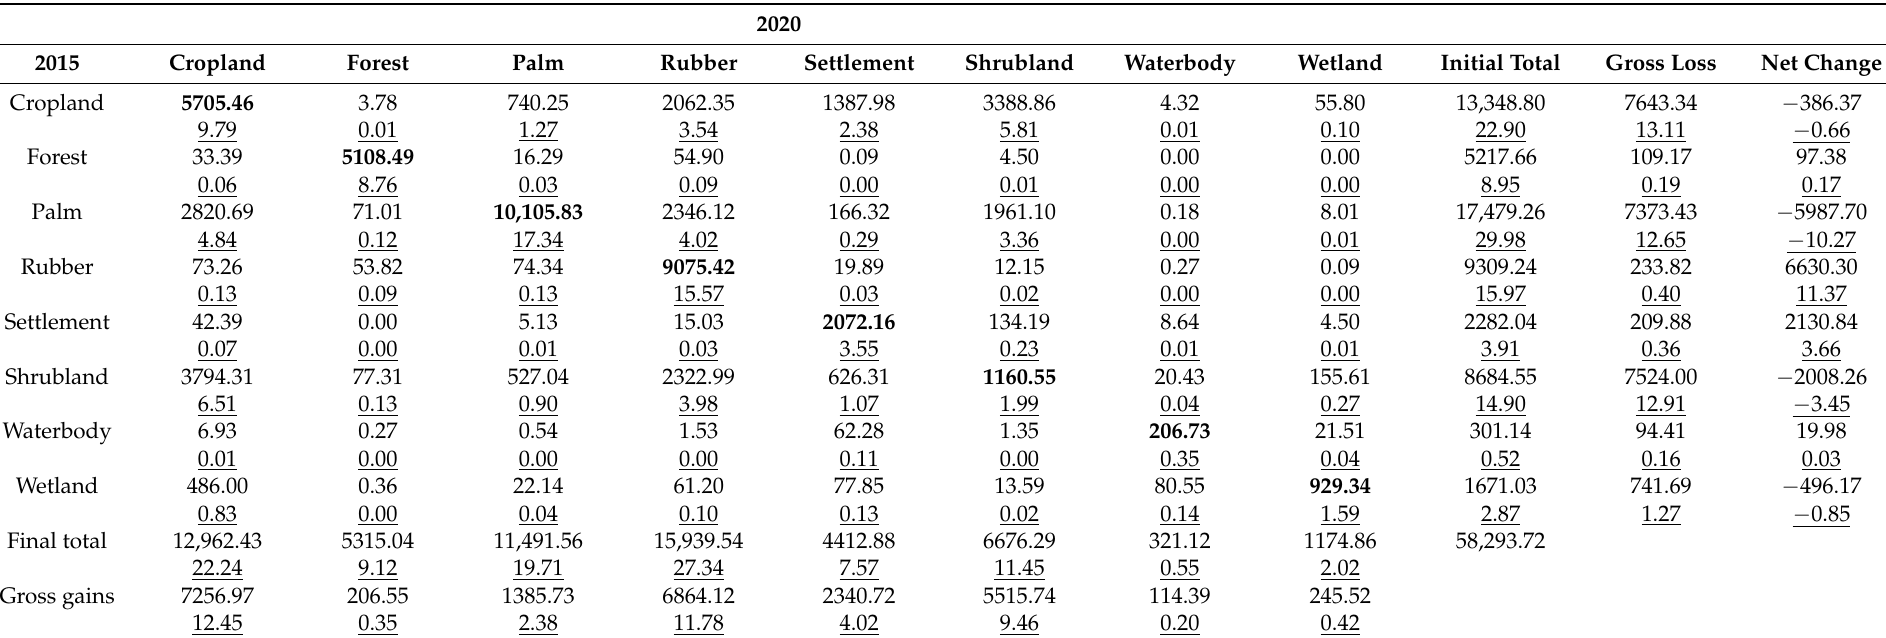
Table A3. Cross tabulation matrices for 2002–2015 area in ha (top values), percentage of total land area (bottom value underlined); the diagonal (in bold) values indicate the persistence of land cover